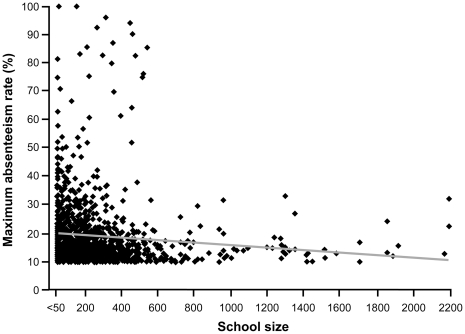
Distribution of the maximal absenteeism rate by school size (all schools) and regression line.